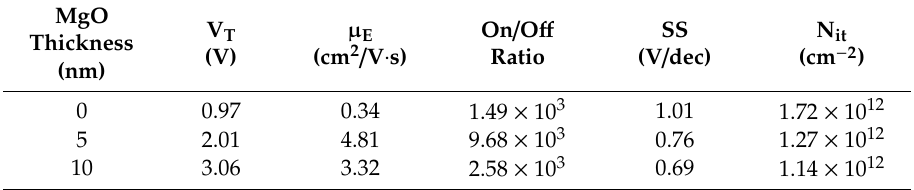
Table 3. Transfer characteristics of MIO TFTs with and without MgO bu ff er